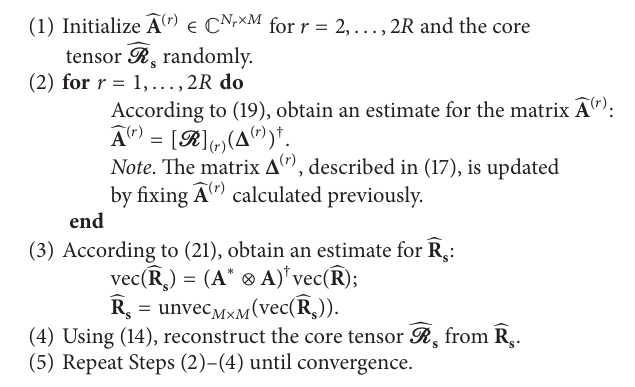
Algorithm 1: Summary of the ALS-Tucker